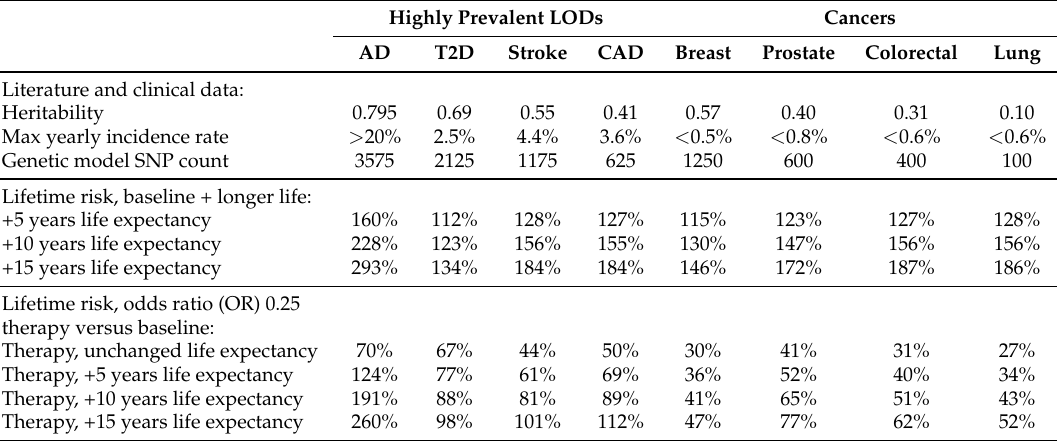
Table 4. LOD characteristics and lifetime risk in a range of life expectancy scenarios and with prophylactic gene therapy lowering population PRS